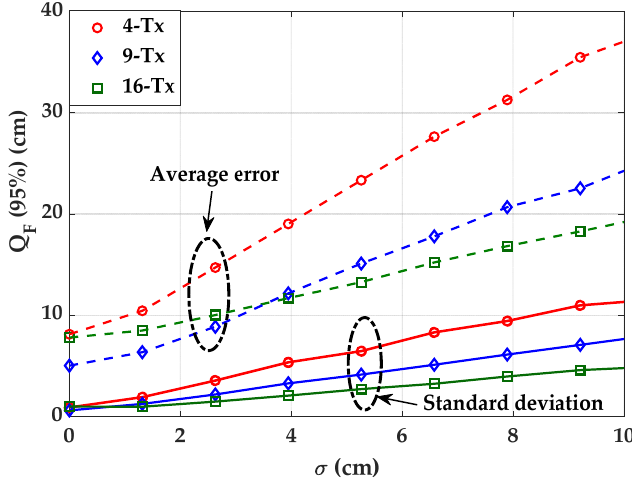
Figure 10. Comparison of positioning error for different Txs and σ .